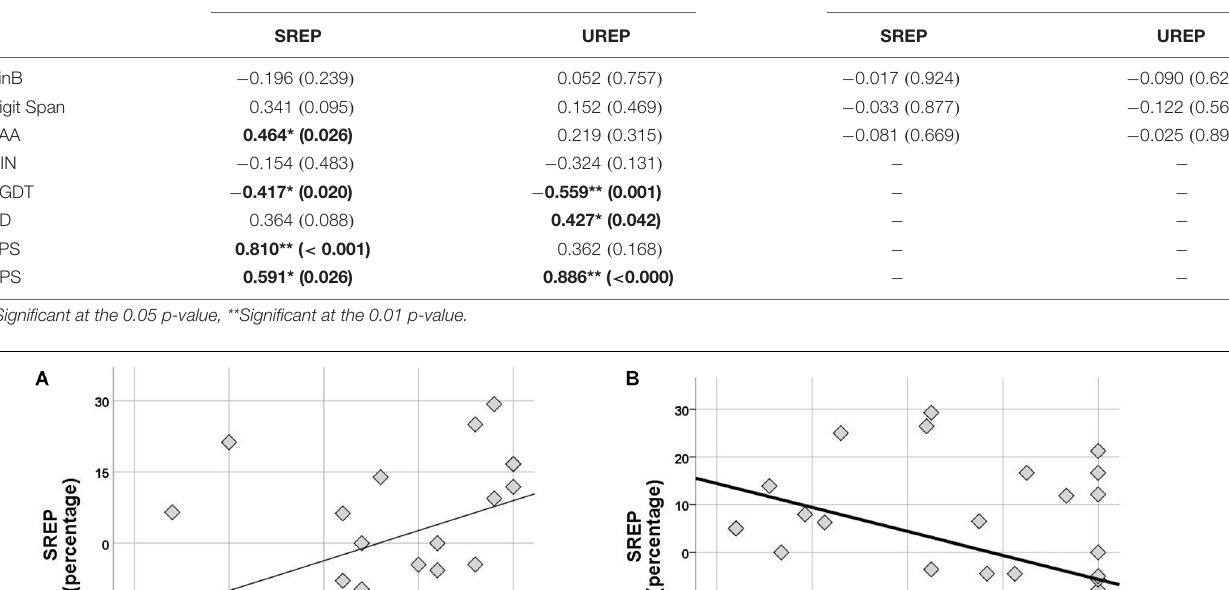
TABLE 3 | Correlation analysis results between SREP and UREP scores vs. SinB, Digit Span, SAA, GIN, RGDT, DD, PPS, and DPS performance for APD and control group. APD group Control group